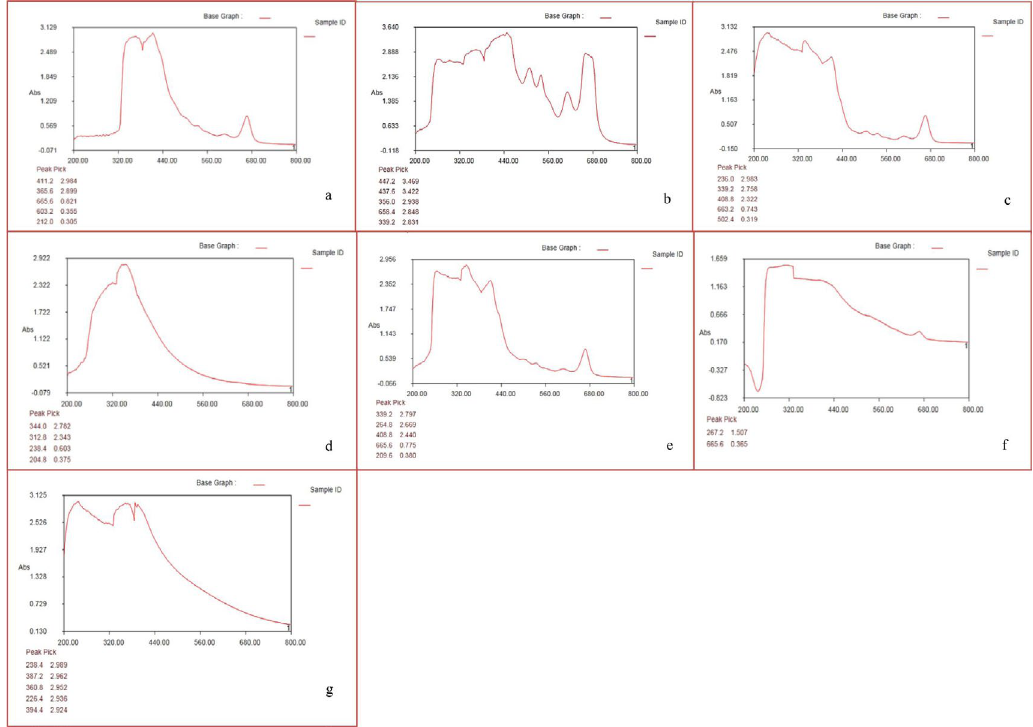
Fig. 3. UV-VIS spectrogram peaks of different extracts {(a) acetone (b) acetonitrile (c) chloroform (d) ethanol (e) ethyl acetate (f) methanol and (g) water} of P.